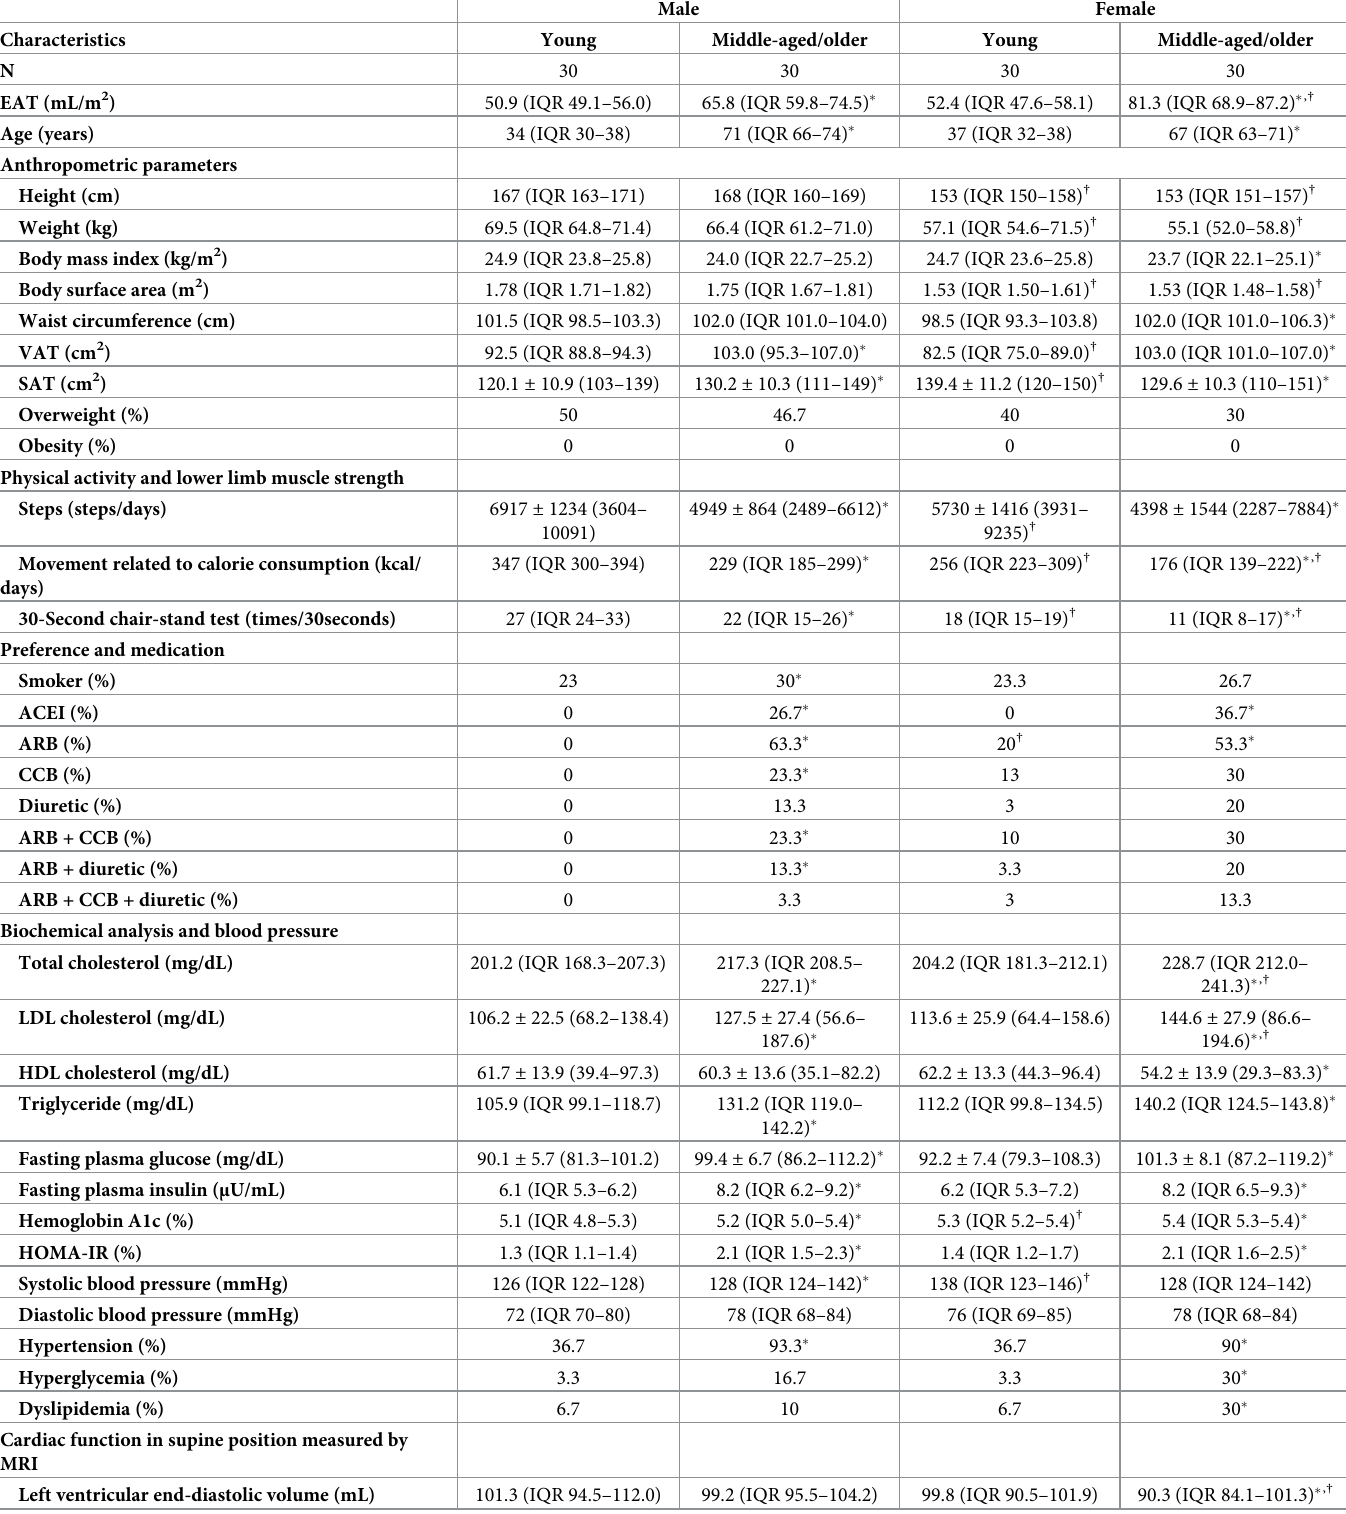
Table 1. Characteristics of the participants classified by age and sex.